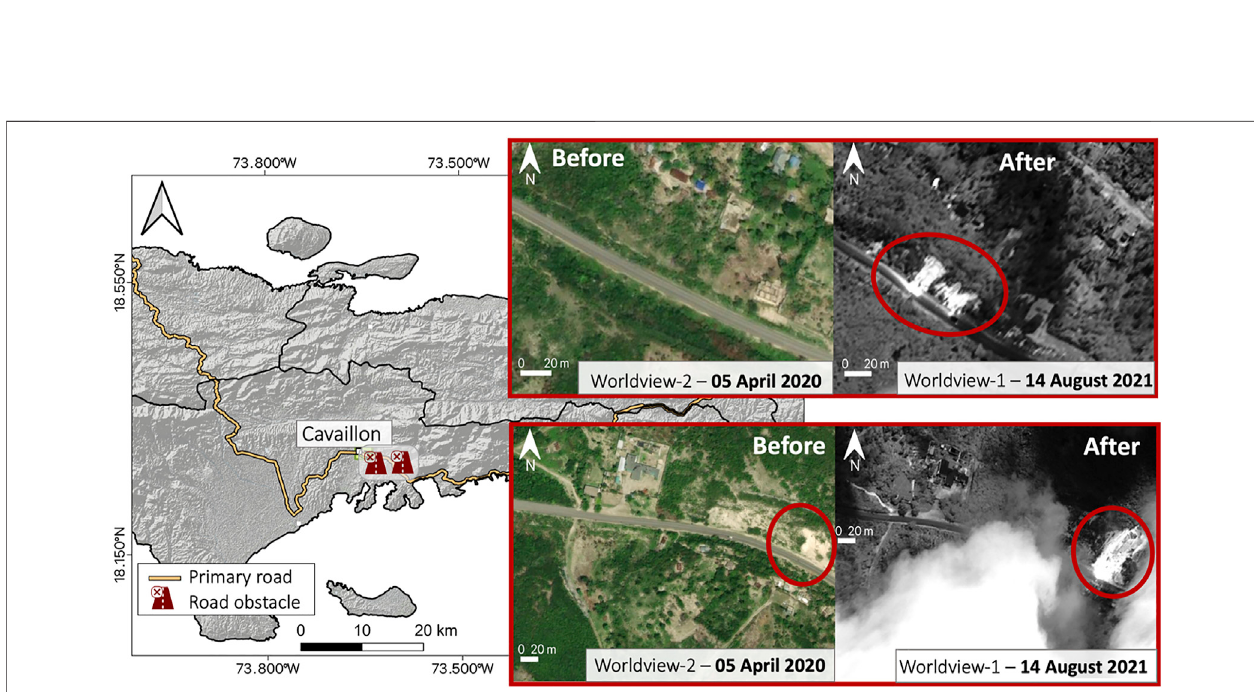
FIGURE 9 | Worldview 1 and 2 imagery used to evaluate impact of landslides on infrastructure. Optical imagery are from the MAXAR Open Data Program.